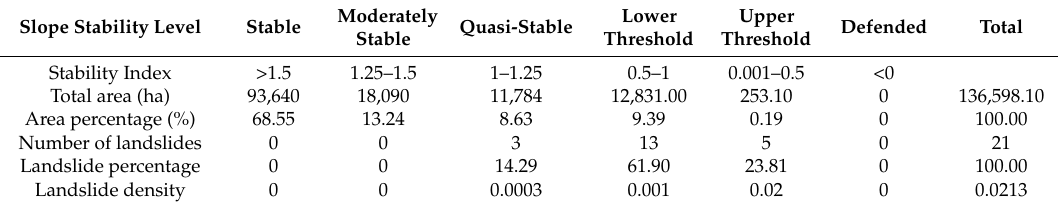
Table 3. Statistical results of the stability index of landslide hazards in the Buleleng